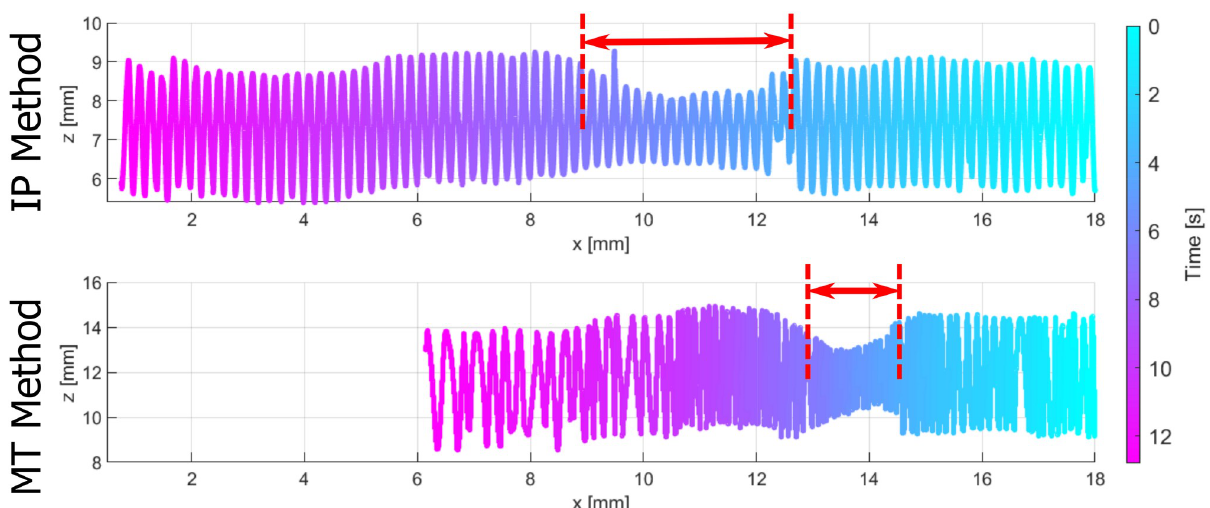
Fig 9. Complete IP volume reconstruction compared to MT volume reconstruction for the bending profile.